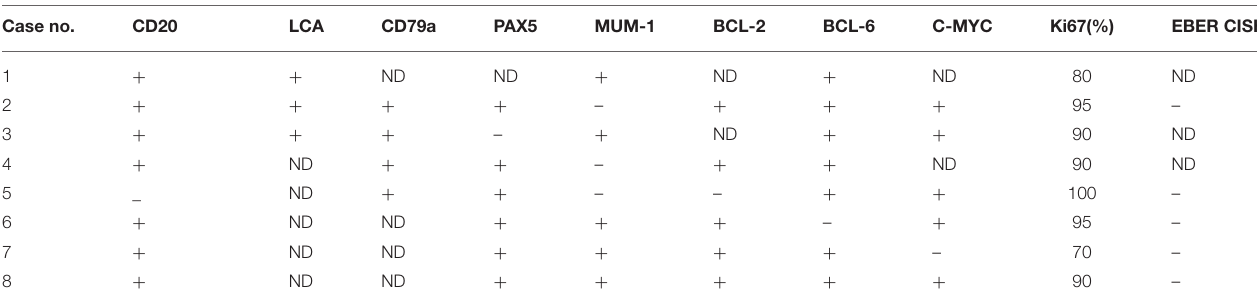
TABLE 2 | Pathological features of 8 patients. Case